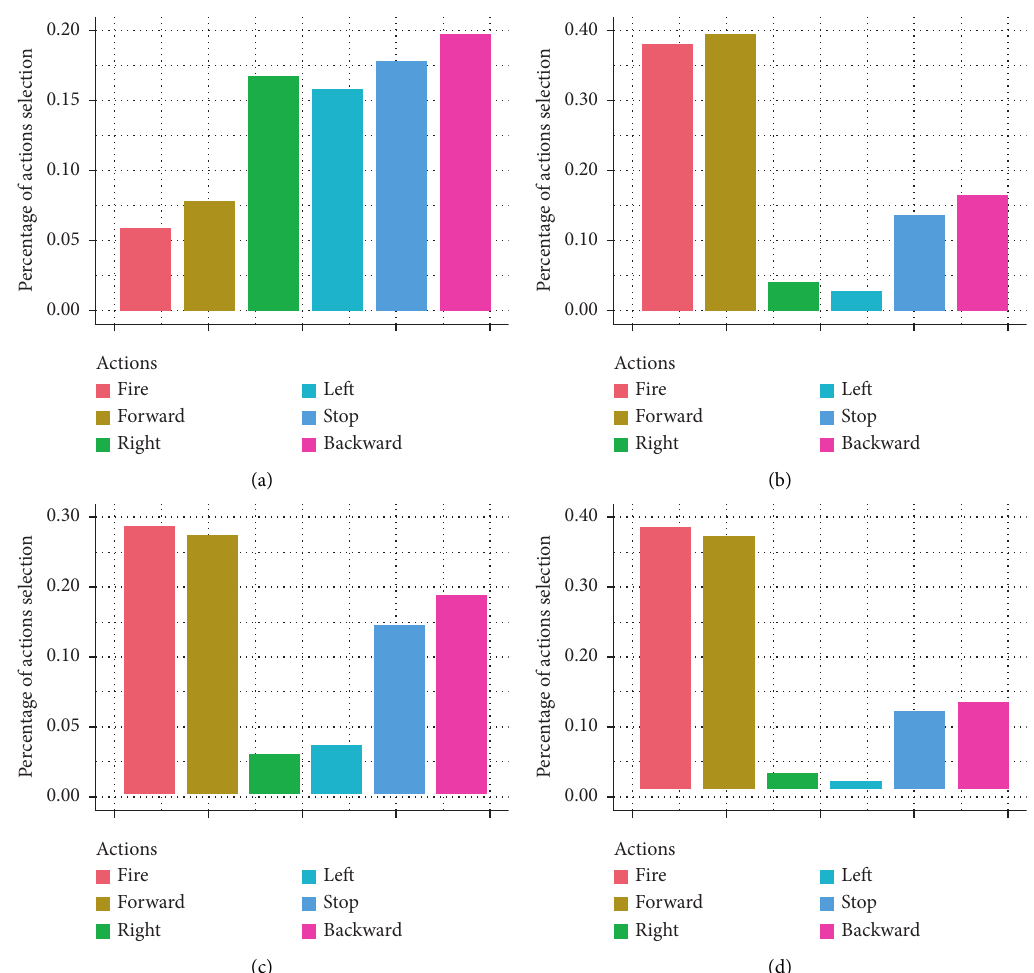
Figure 7: Percentage of actions selected in the 1 st , 2 nd , 3 rd , and 4 th quarters of the training phase against “SittingDuck.”